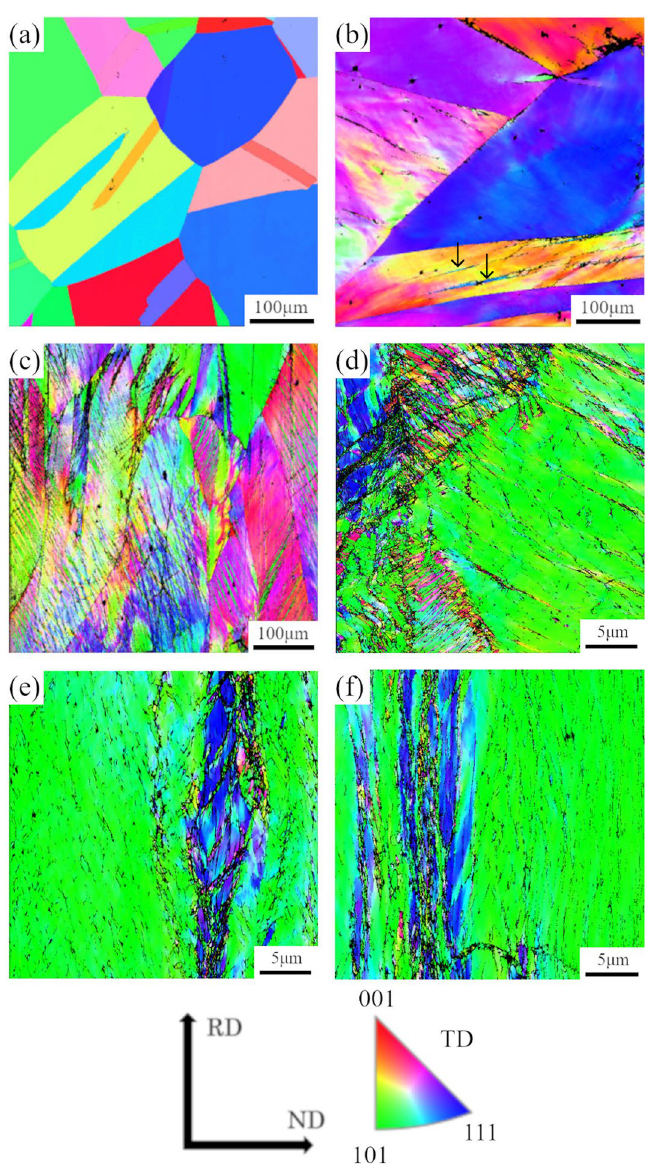
Figure 1. IPF maps of TD planes of CrMnFeCoNi alloy with rolling reduction of ( a ) 0%, ( b ) 20%, ( c ) 40%, ( d ) 60%, ( e ) 80%, and ( f )